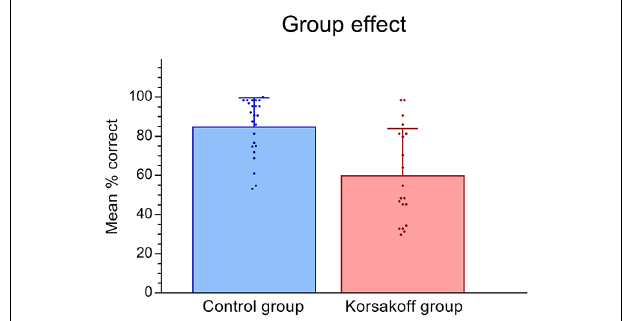
FIGURE 3 | Means and standard deviations for Korsakoff’s patients vs. controls. Scatter dots show individual mean performance for all conditions.